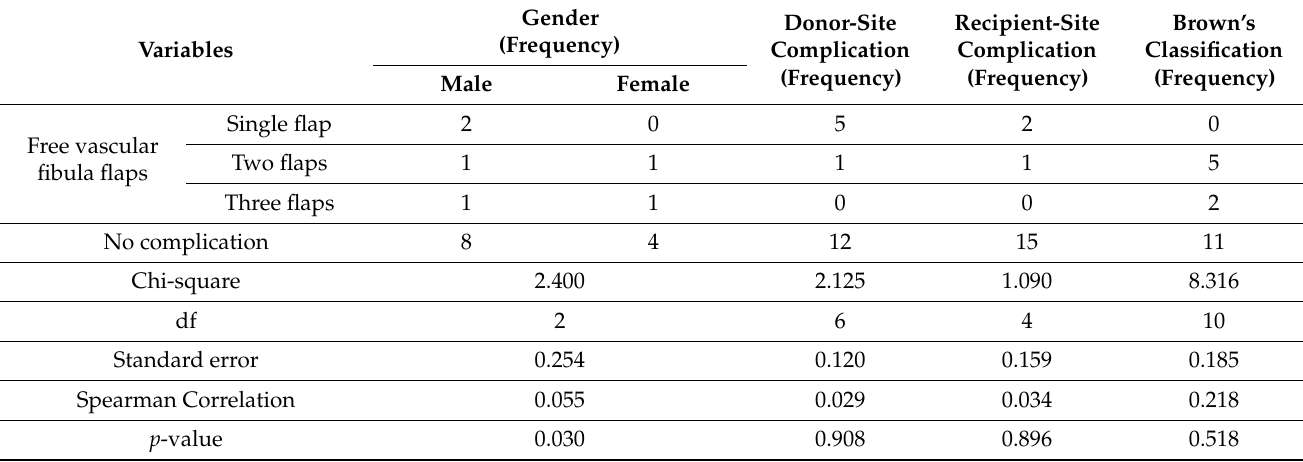
Table 5. Association of independent variables with free vascular flaps ( n =